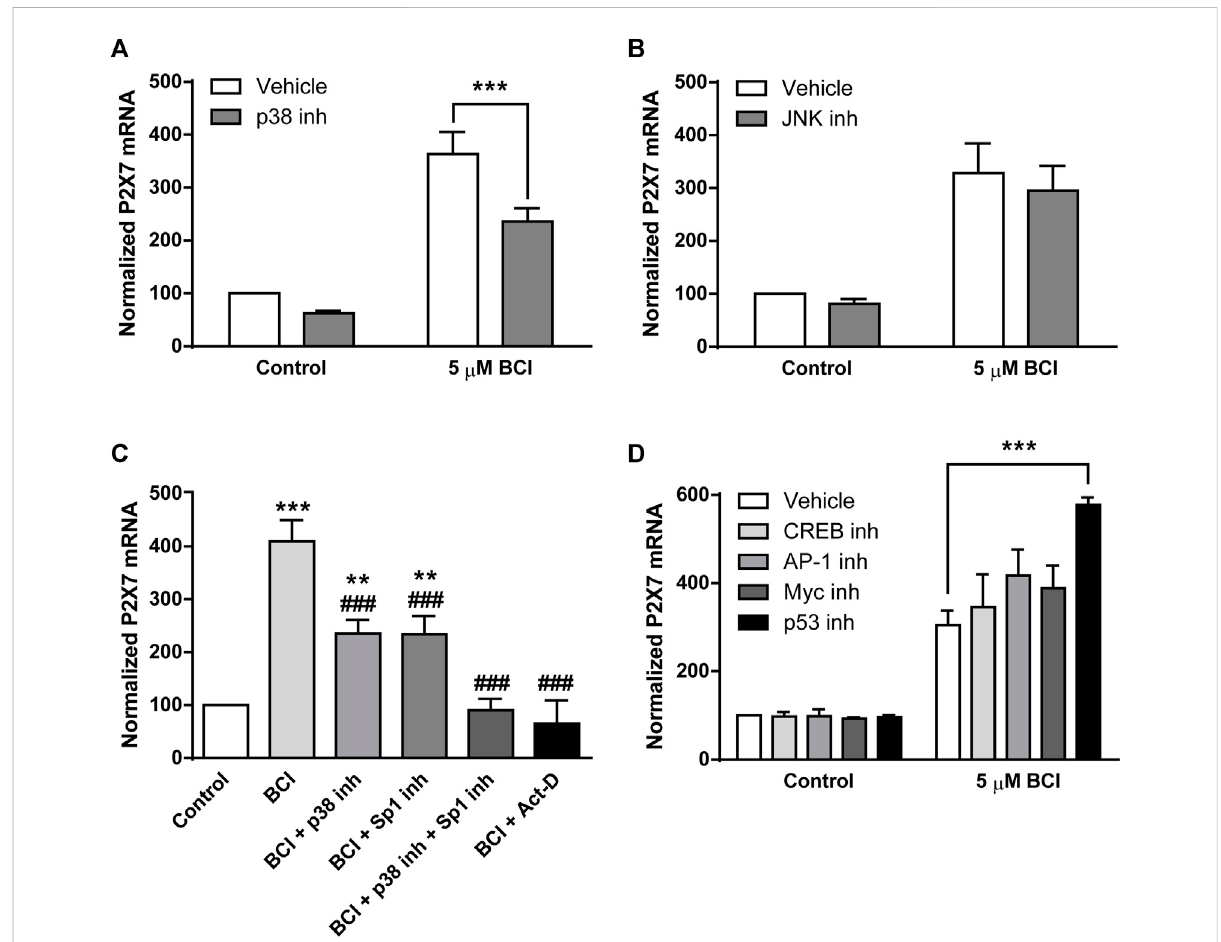
The inhibition of p38 prevents BCI-dependent overexpression of P2RX7 in neuroblastoma cells. N2a cells cultured in SFM were treated with inhibitors of (A) p38(10 μ M,SB202190)or (B) JNK(10 μ M,SP600125) for10 minbeforetheadditionfor24 hofeitherBCI (5 µM)orthevehiclealone (control). Then, total RNA was extracted from the cells and quanti fi ed. The data were normalized to the P2RX7 transcript levels in untreated cells cultured in SFM (set as 100%). The results are the mean ± SEM of six independent experiments in triplicate *** p ≤ .001 vs. vehicle. (C) N2a cells cultured in SFM were treated for 10 min with inhibitors of Sp1 (300 nM, mithramycin A), p38 (10 μ M, SB202190) or both before adding BCI (5 µM) for 24 h. The transcriptionalinhibitor actinomycin D(5 µM)was also assayed. Total RNAwas then extracted from thecells andquanti fi ed.The data were normalized to the P2RX7 transcript levels in control cells cultured in SFM (set as 100%). The results are the mean ± SEM of fi ve independent experiments performed in triplicate ** p ≤ .01, *** p ≤ .001 vs. control; ### p ≤ .001 vs. 5 μ M BCI. (D) N2a cells cultured in SFM were treated for 30 min with inhibitors of CREB (1 μ M, 666-15), AP-1 (10 μ M, SR11302), Myc (20 μ M, KJ Pyr 9) or p53 (20 μ M, cyclic pi fi thrin- α ) before the addition of BCI (5 µM) or the either alone (control) for 24 h. Afterwards, total RNA was extracted from the cells and quanti fi ed. The data were normalized to the P2RX7 transcript levels in control cells cultured in SFM (set as 100%). The results are shown as the mean ± SEM of six independent experiments performed in triplicate *** p ≤ .001 vs.